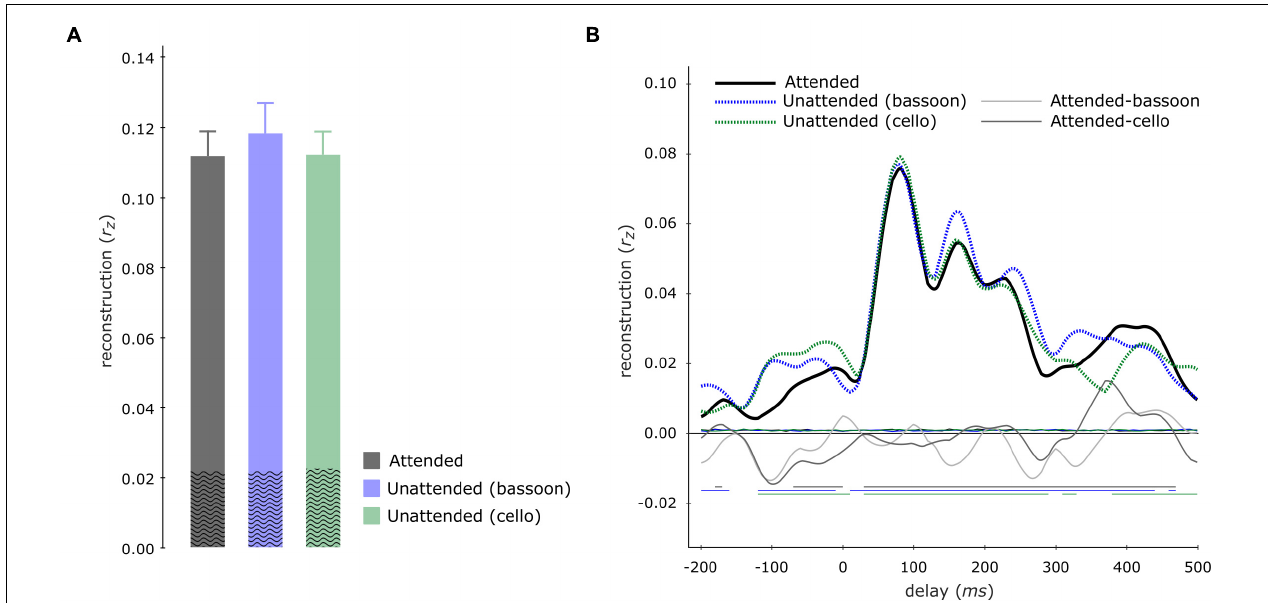
FIGURE 6 | Aggregate tracking during integration and segregation tasks. Multi-delay model tracking performance (A) for the aggregate during the aggregate (gray), bassoon (blue), and cello (green) tasks, displaying no significant differences between model tracking capacities. The average empirical chance-level is displayed as superimposed black waves. Single-delay aggregate tracking profiles (B) showing tracking performance for the aggregate (black solid line), bassoon (blue dashed line), and cello (green dashed line) tasks. Differences between attention to aggregate and the attention to bassoon of tracking are shown by thin light-gray and dark-gray lines, respectively. Thin horizontal wavy lines within the plot indicate the average empirical chance-level. Horizontal lines at negative tracking values at the bottom of the graph indicate those time-points which displayed significant tracking